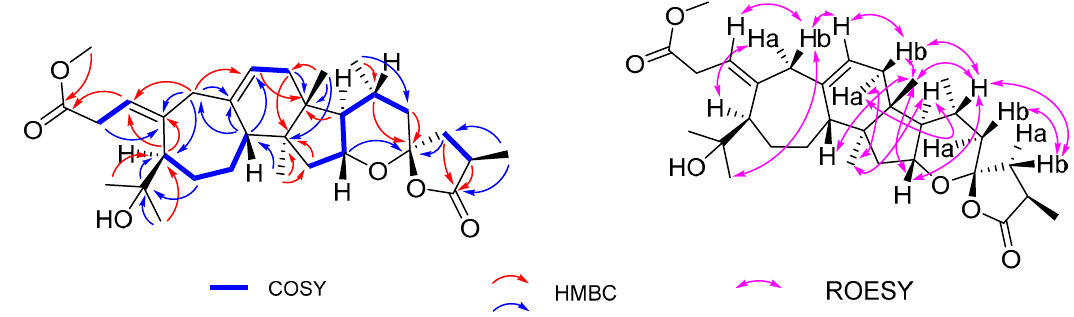
Figure 2. Key COSY, HMBC, and ROESY correlations for compound 1.